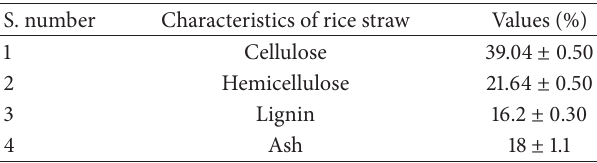
Table 1: Chemical composition of rice straw variety (Pusa Sugandh)